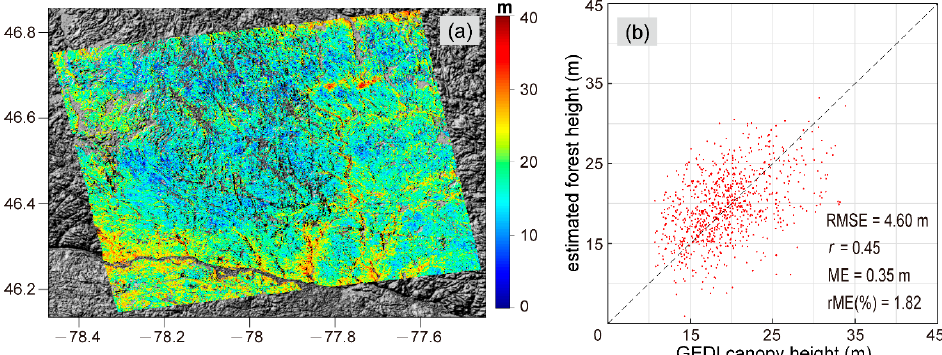
Figure 9. ( a ) The inverted forest height. ( b ) Validation plot of estimated forest height versus GEDI canopy height.